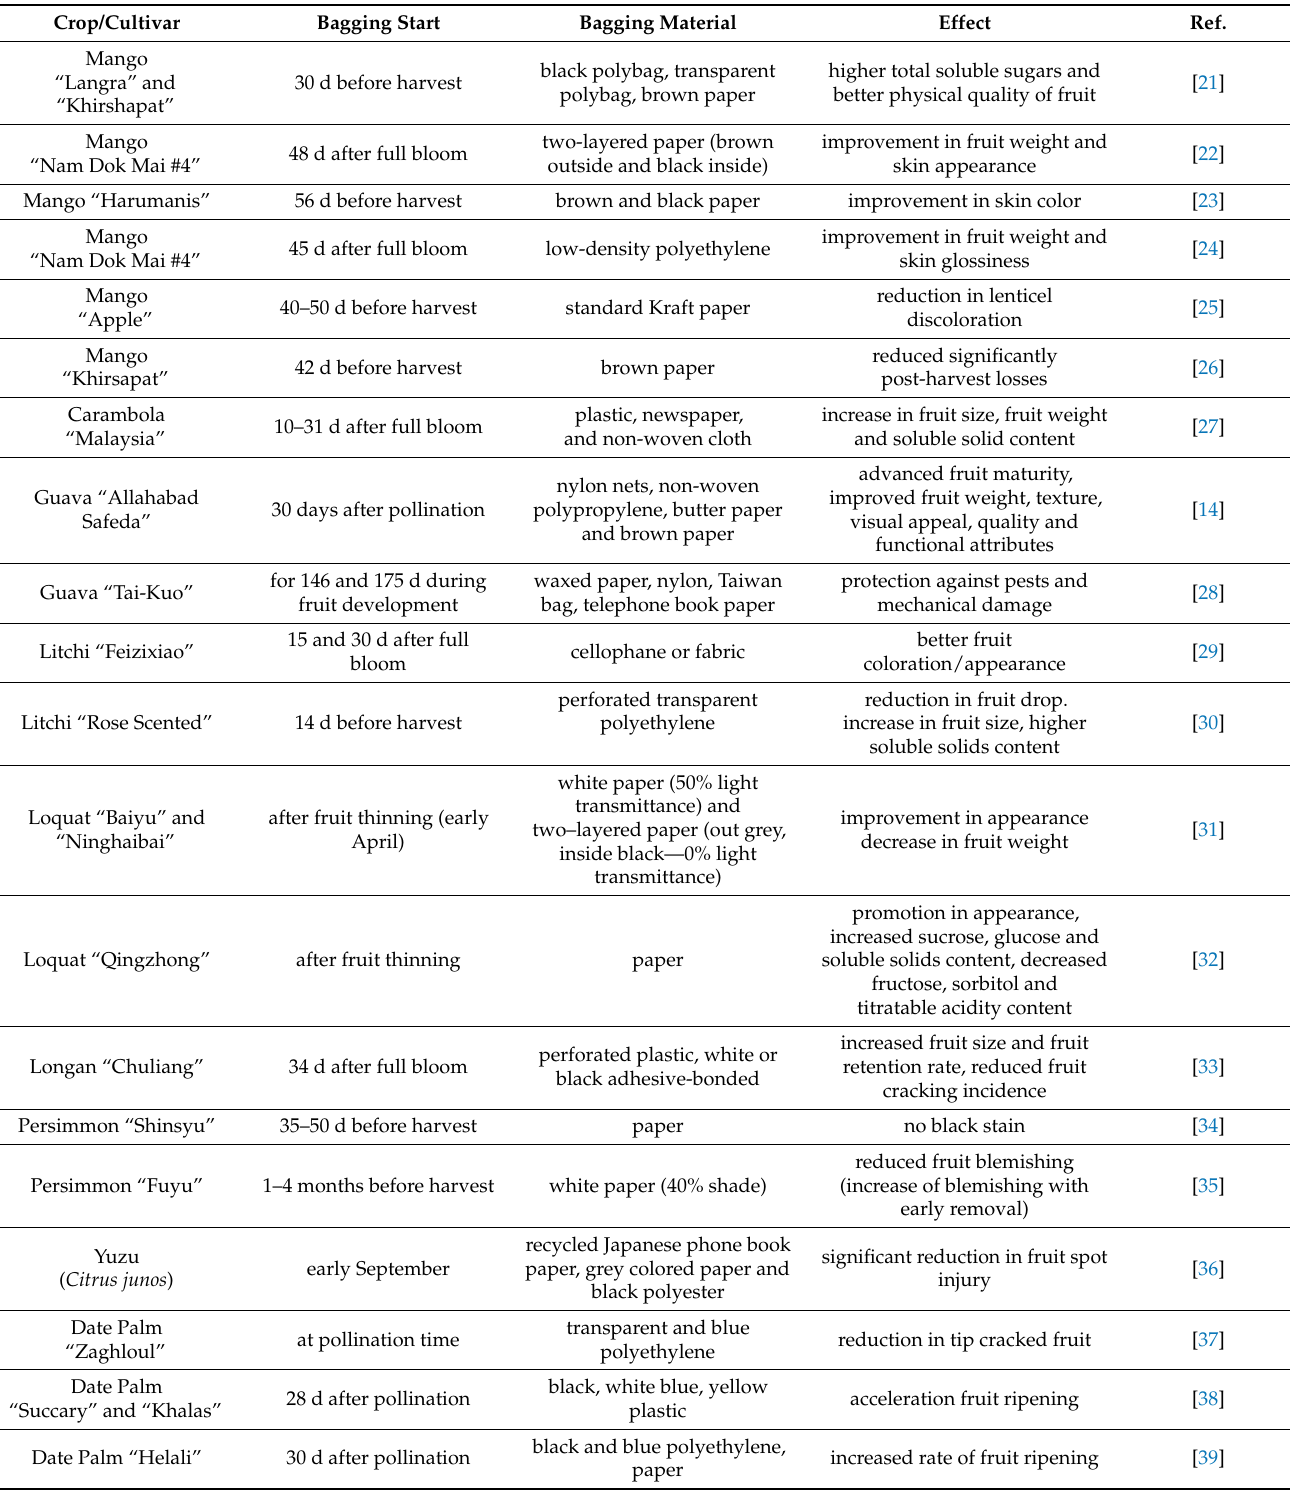
Table 1. The effects of bagging on color, quality and physiological disorders of some tropical fruits.